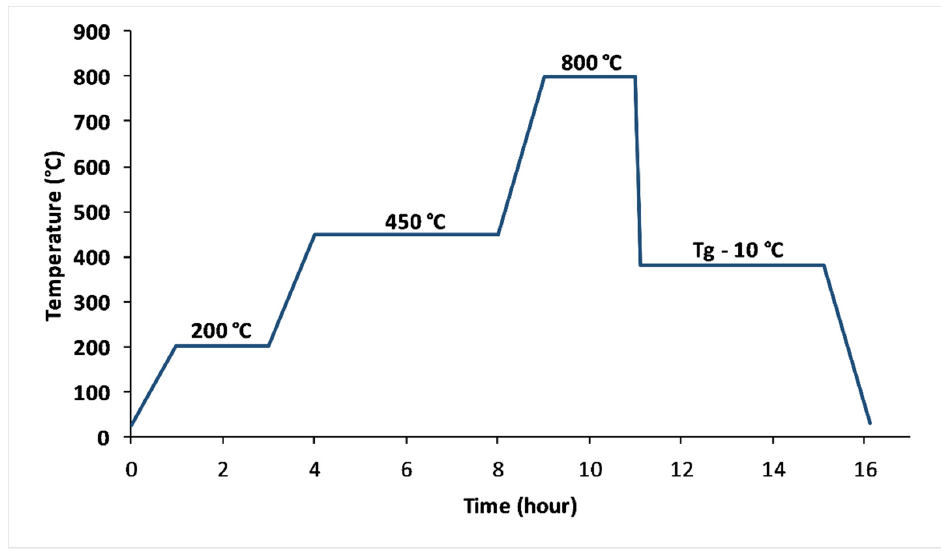
Figure 10. Thermal profile used to elaborate glasses.